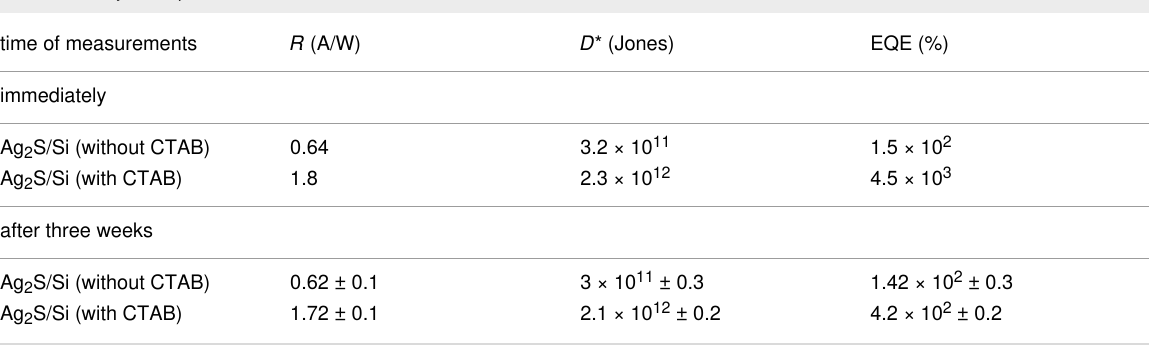
Table 2: Stability of the photodetectors.